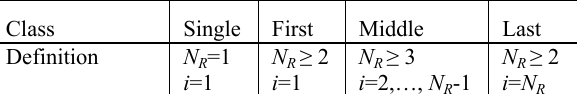
Table 1. Subdivision of points into classes in dependence on